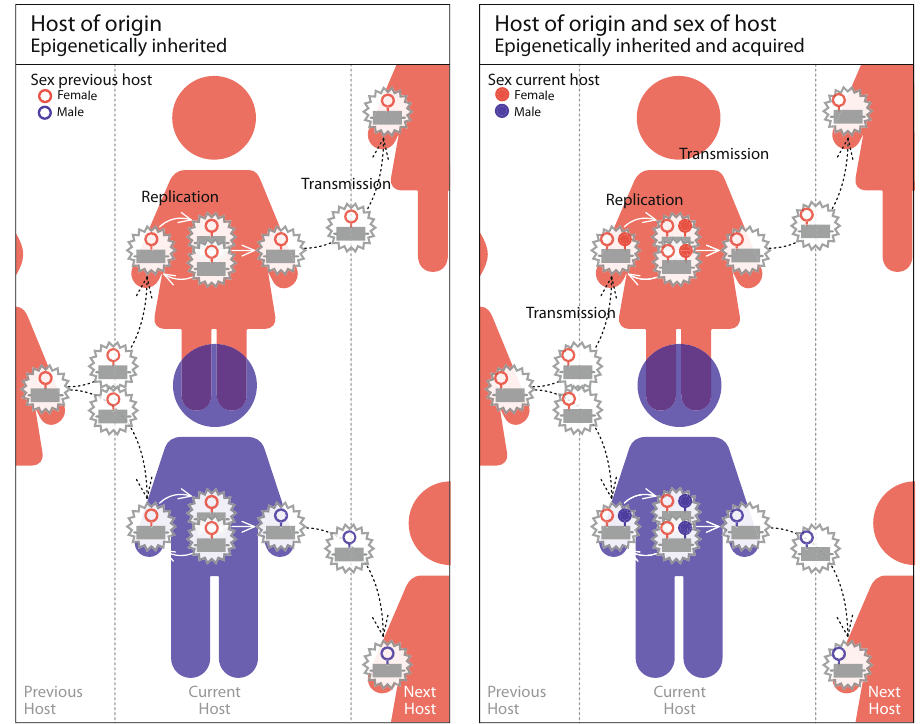
Fig. 2 Cycle of epigenetic marks on pathogens. The fi rst panel represents the cycle of epigenetically inherited marks on pathogens, that is marks underpining origin-speci fi c virulence. The second panel represents the cycle of epigenetically inherited and acquired marks on pathogens, that is marks underpining origin-&-sex-speci fi c